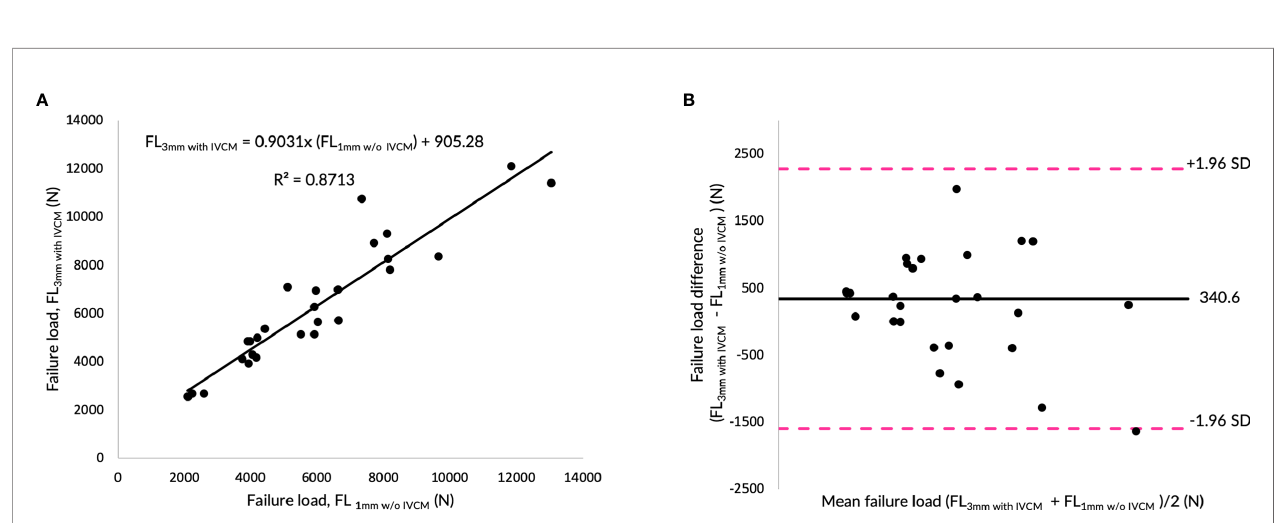
FIGURE 5 | Routine clinical image data for fi nite element (FE)-Analysis. (A) Correlation plot between FE-predicted failure load values for high-resolution and routine image data, and (B) Bland Altman plot representing the mean of FE-predicted failure load values versus difference between them in for high-resolution and routine image data scan settings, respectively. Horizontal lines represent mean and dashed line ±1.96 standard deviation. FL represents FE-predicted vertebral failure load